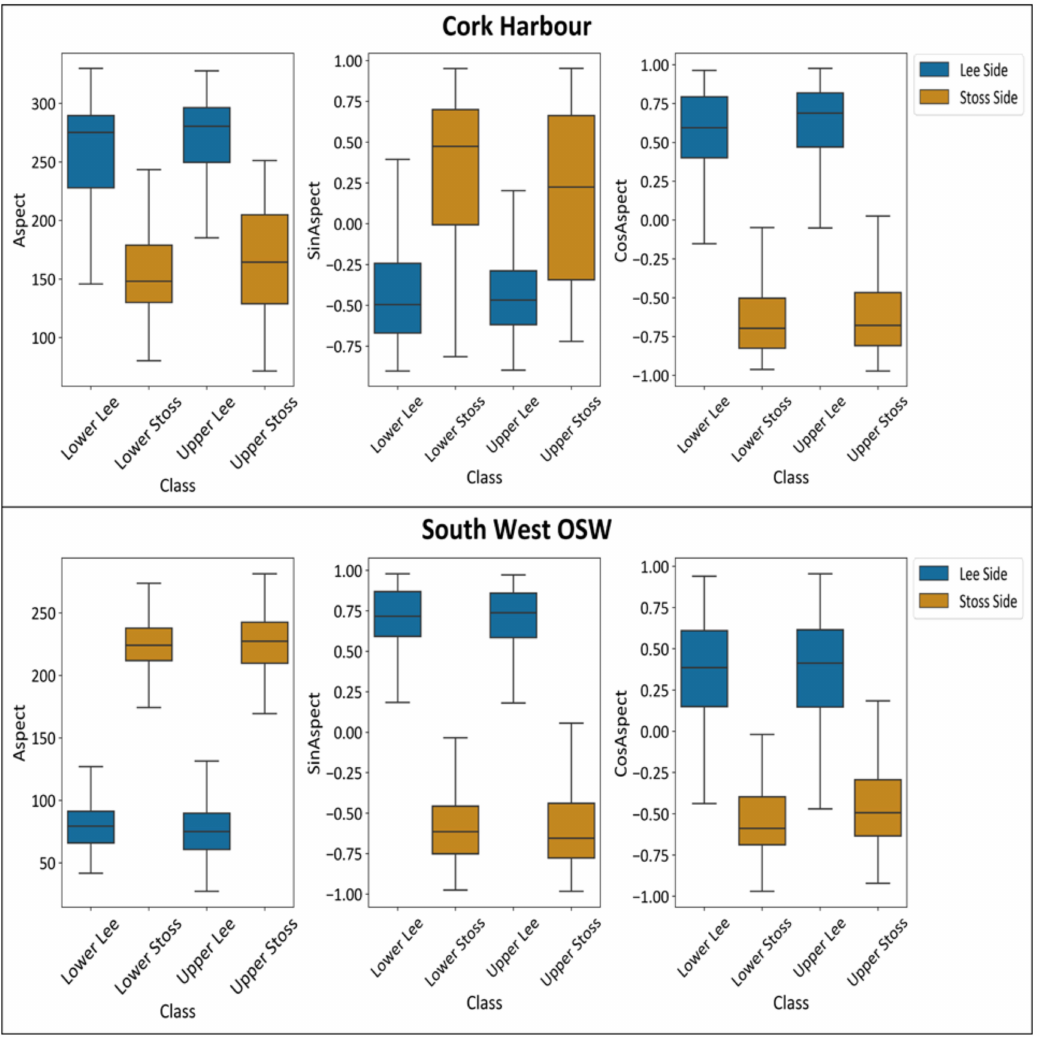
Figure 13. Mean aspect, sinaspect, and cosaspect for the four separate classes for both the Cork study site and the South-West OSW